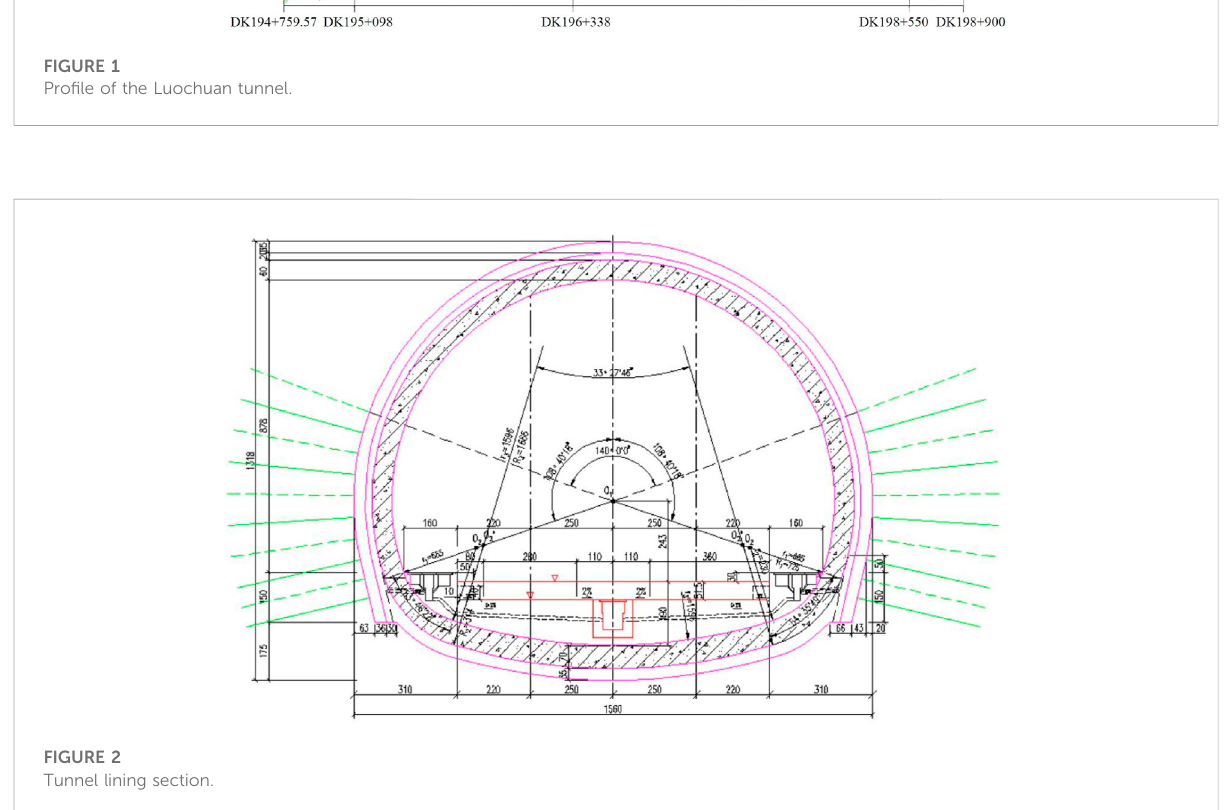
FIGURE 2 Tunnel lining section.